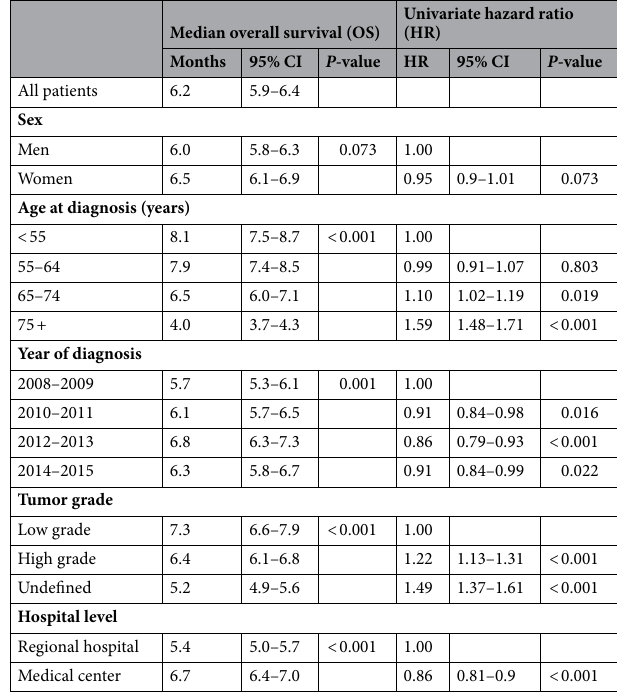
Table 2. Median overall survival and hazard ratio of M1 Stage IV gastric cancer patients by demographic characteristics and treatment modalities from 2008 to 2015 in Taiwan.